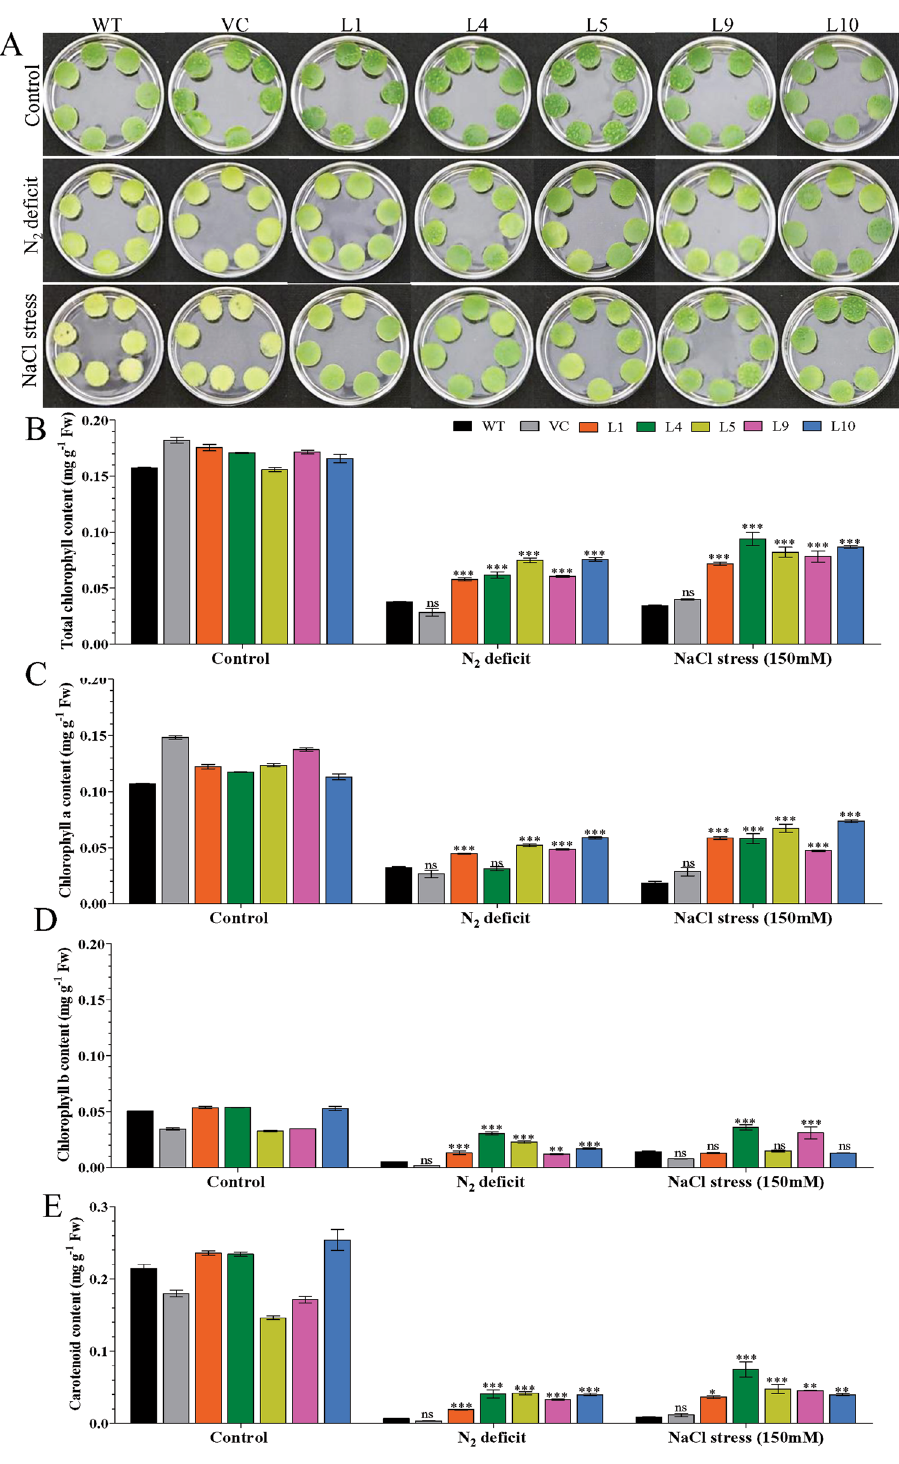
Figure 5. Photosynthesis efficiency analysis of transgenic plants. Comparative analysis of ( A ) leaf senescence and photosynthetic pigments, ( B ) total chlorophyll, ( C ) chlorophyll a, ( D ) chlorophyll b, ( E ) carotenoid in transgenic lines, WT and VC plants under control, nitrogen deficit and salt stress condition. Bars represent means ± standard error, and ‘*’, ‘**’ and ‘***’ designates for significant differences at P < 0.05, P < 0.01 and P < 0.001,